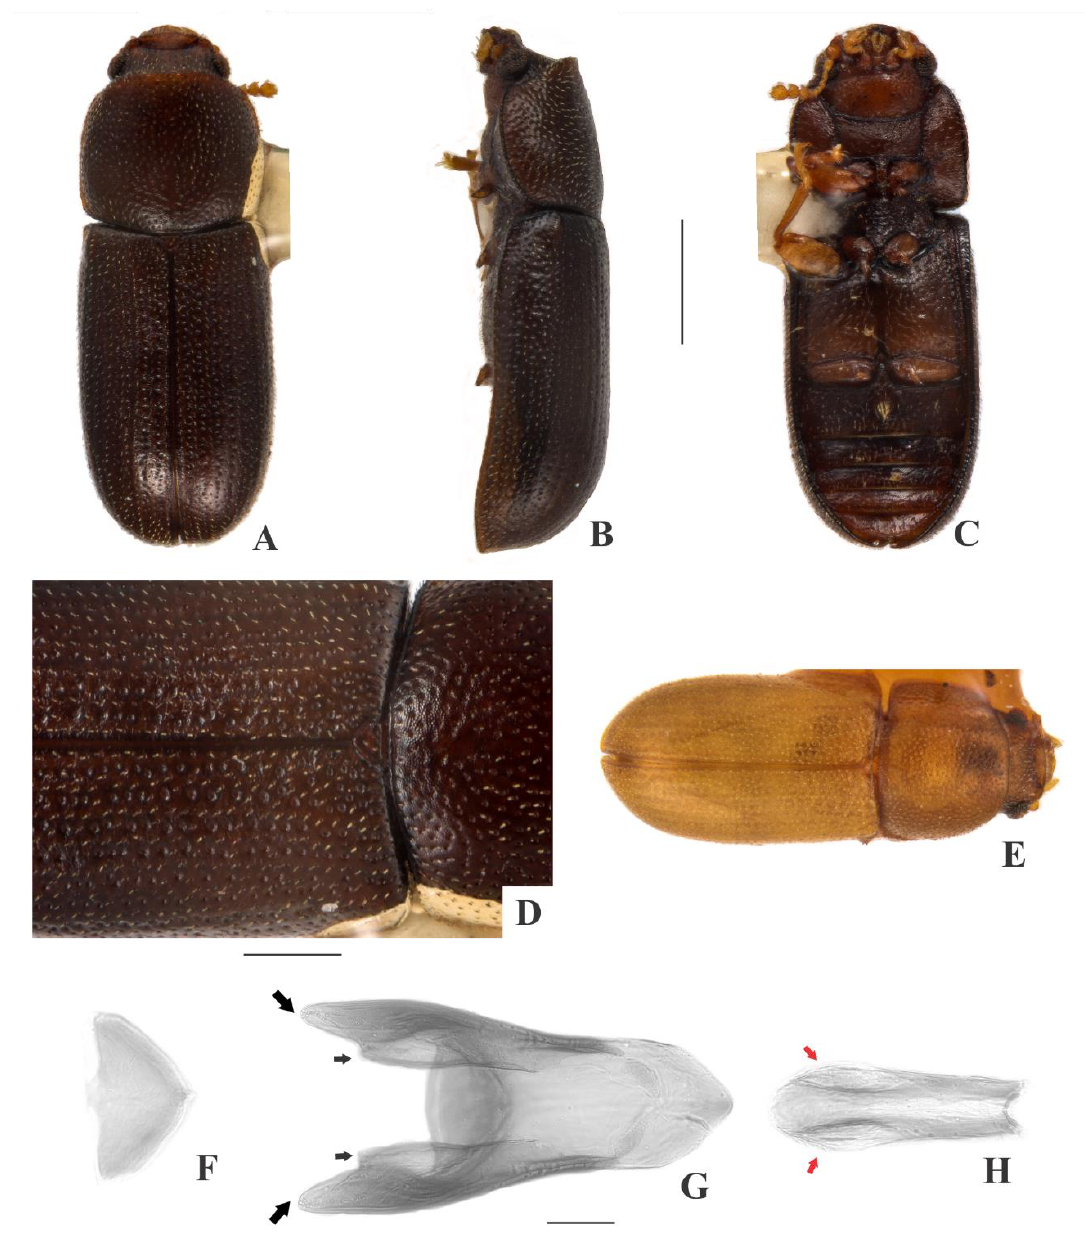
Figure 6. Cis makrosoma sp. n. , male holotype ( A – D ), female paratype ( E ), aedeagus of paratype from type locality ( F – H ): ( A ) Dorsal view. ( B ) Lateral view. ( C ) Ventral view. ( D ) Scutellar shield and part of the pronotum and elytra. ( F ) Basal piece. ( G ) Tegmen, note acute angulations (big black arrows) with rounded corners (small black arrows) at apex. ( H ) Penis. Scale bars: 0.5 mm ( A – C , E ), 0.2 mm ( D ), 0.05 mm ( F – H ).